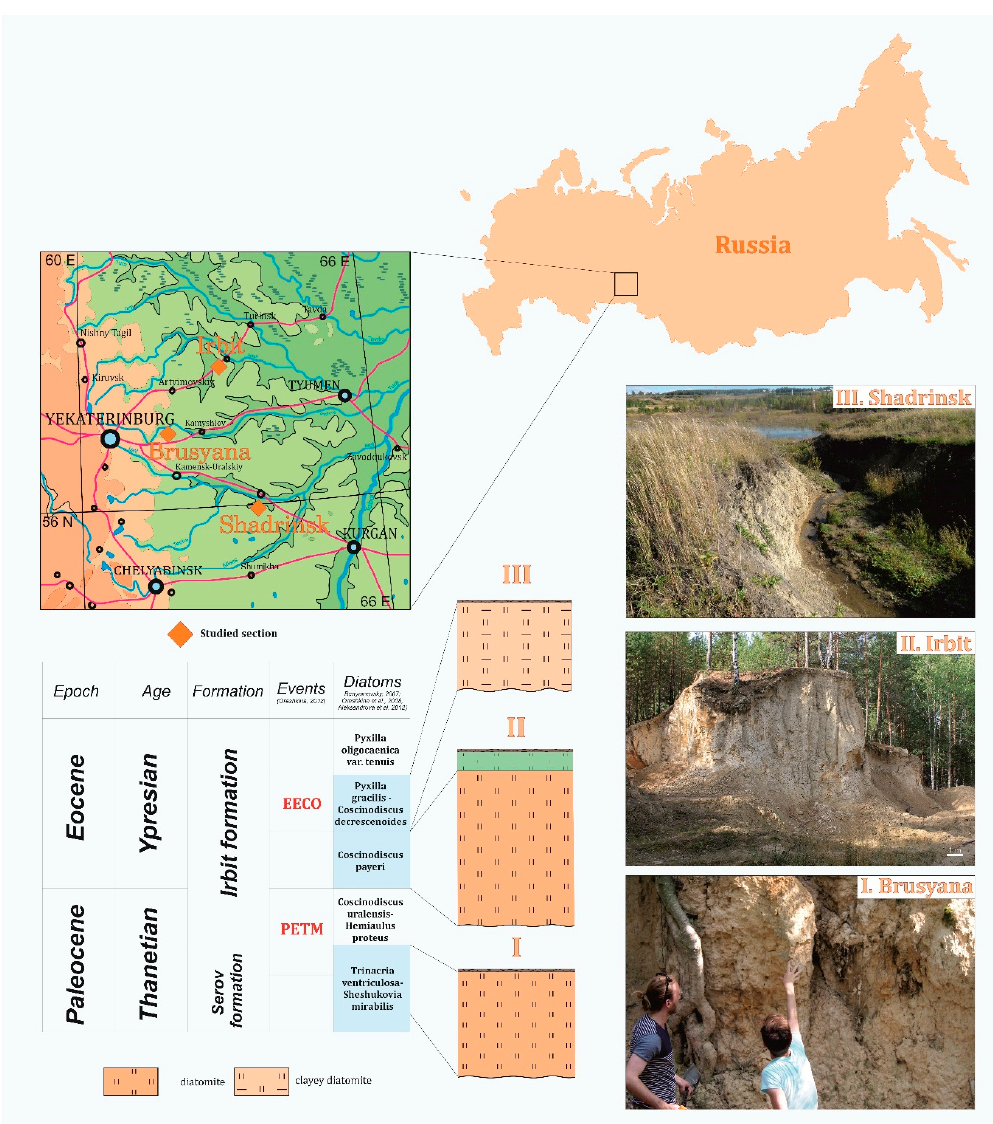
Figure 1. Location objects scheme and stratigraphic settings of the region. PETM—Paleocene–Eocene thermal maximum; EECO—Early Eocene Climatic Optimum. thermal maximum; EECO—Early Eocene Climatic